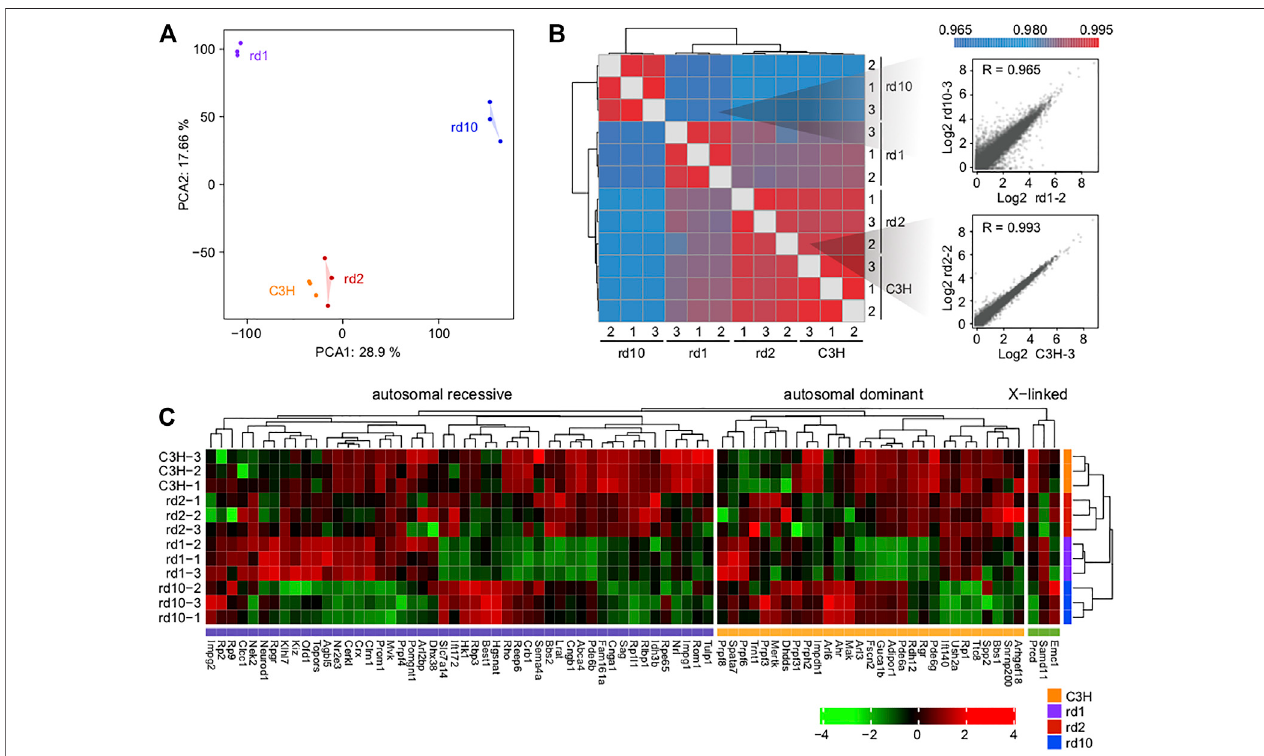
FIGURE2| Overalltranscriptomicpro fi lesofthethreemicemodels. (A) Principalcomponentanalysisand (B) Pearsoncorrelationcoef fi cientsshowingthesimilarity and reproducibility among different biological replicates; (C) The expression levels of inherited retinal disease-associated genes in control and RD mice. Note that rd10 retina expresses Pde6b mRNA, albeit for a catalytically inactive